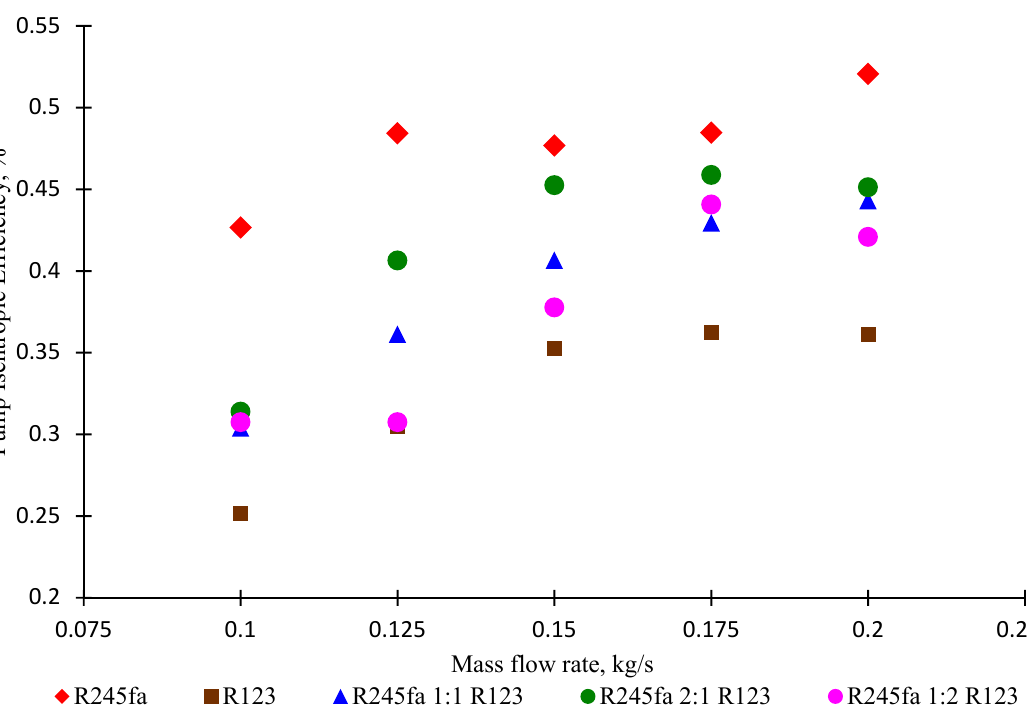
Figure 10. Pump isentropic efficiency as a function mass flow rate for R245fa, R123, and mixed working fluids with heat source at 110 ° C.